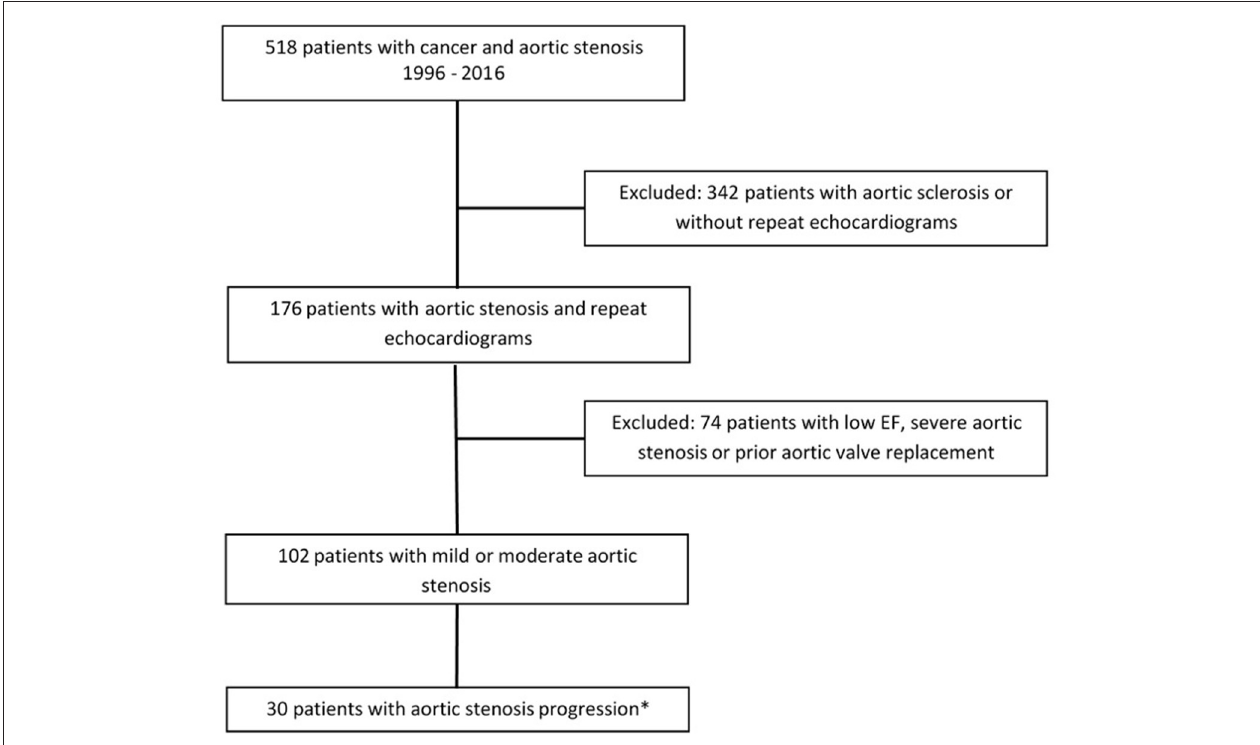
FIGURE 1 | Study design. *Aortic stenosis progression defined as differential Vmax > 2 or mean gradient > 20 mmHg or need for aortic valve